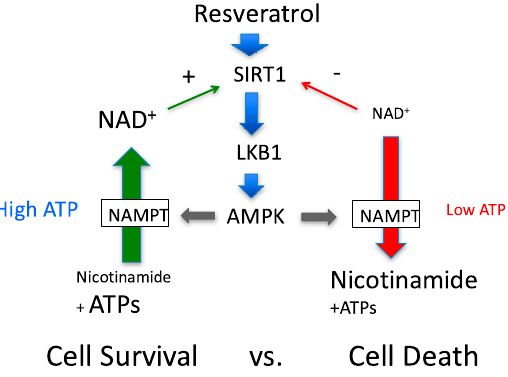
Figure 7. Revised proposed feedback loop to determine cell survival and cell death. Since NAD + synthesis requires several ATPs, ATP availability will determine the effects of the feedback loop. Different amounts ATP, nicotinamide and NAD + are presented using different font